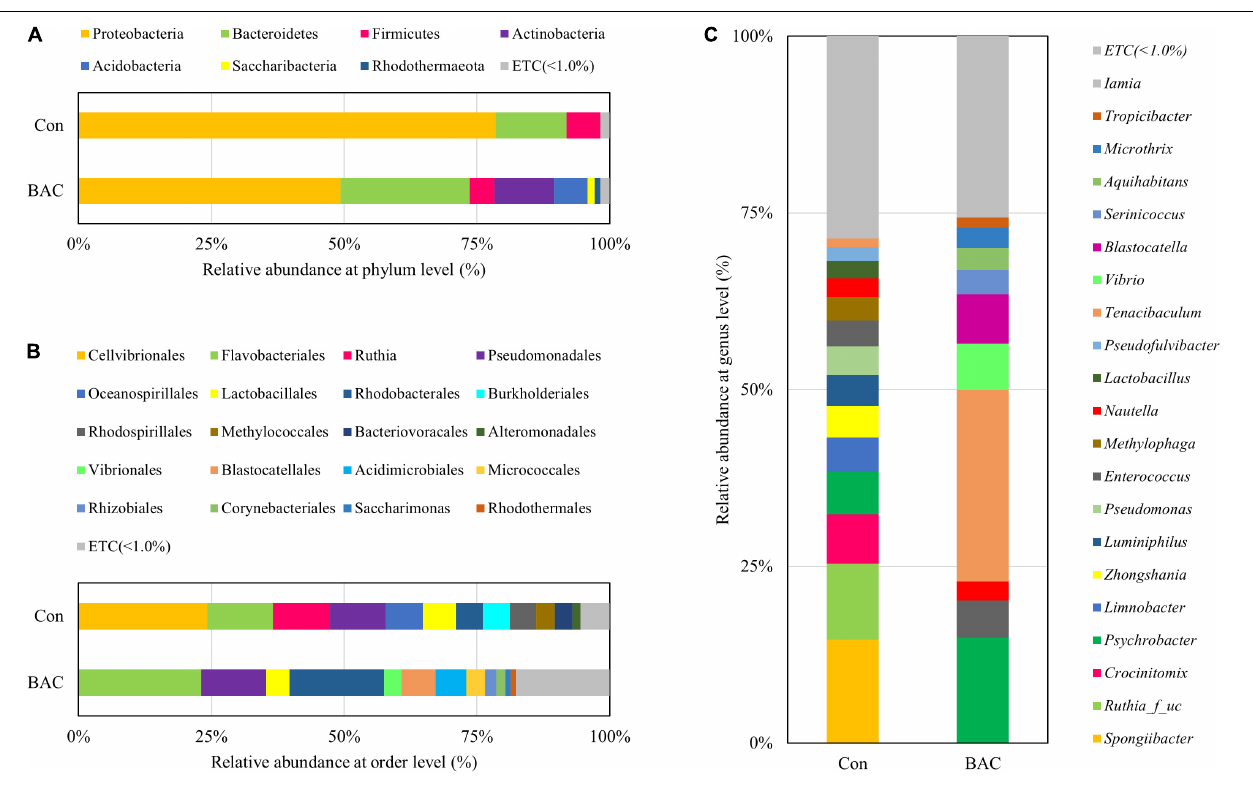
FIGURE 2 | Average composition and relative abundance of bacterial communities of Anguilla japonica fed different diets at the phylum (A) , order (B) , and genus (C)